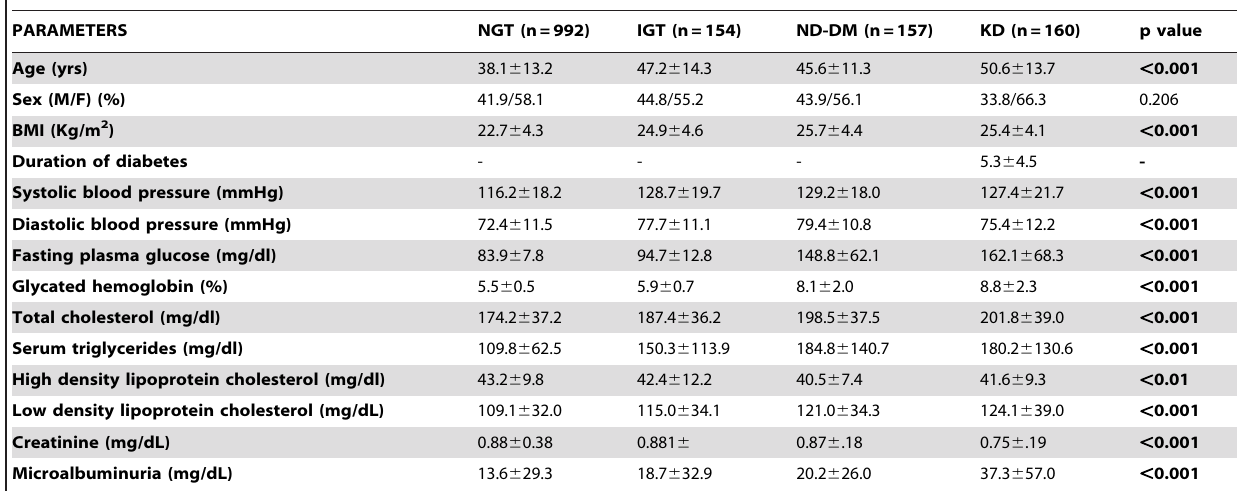
Table 1. Clinical and biochemical characteristics of study